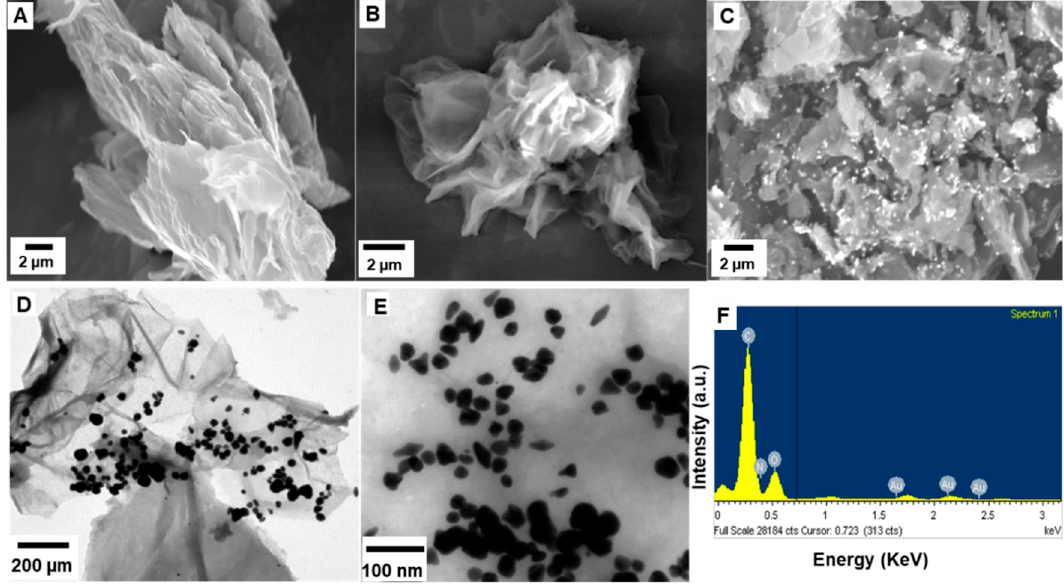
Figure 3. ( A ) SEM images of rGO, ( B ) rGO / PDA, and ( C ) rGO / PDA / AuNPs. ( D , E ) TEM images of rGO / PDA / AuNPs at di ff erent magnifications. ( F ) EDX spectrum of rGO / PDA / AuNPs.